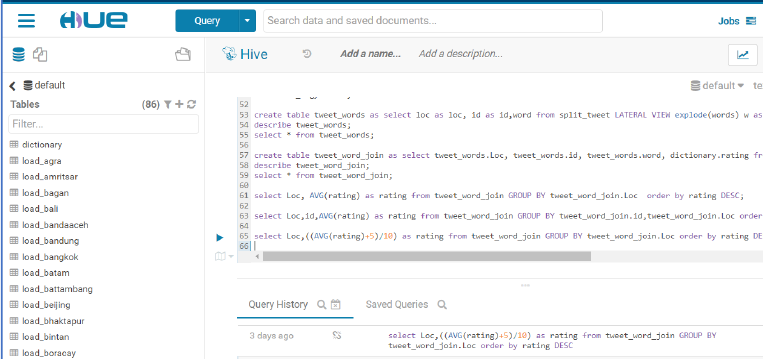
Figure 20. Twitter messages sored in HDFS using HUE with Hive